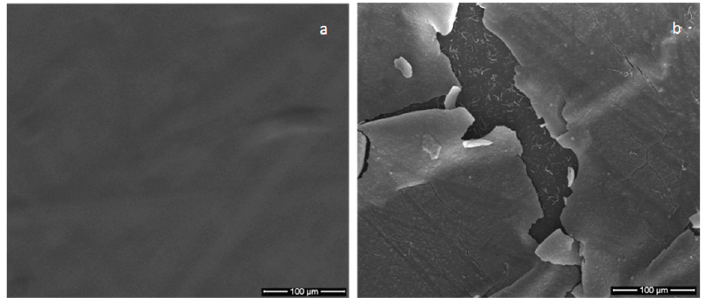
Figure 8. SEM image of: ( a ) polymer substrate; ( b ) calcium phosphate coating generated in a continuously single run in magnetron sputtering discharge for 2 h with no pauses.